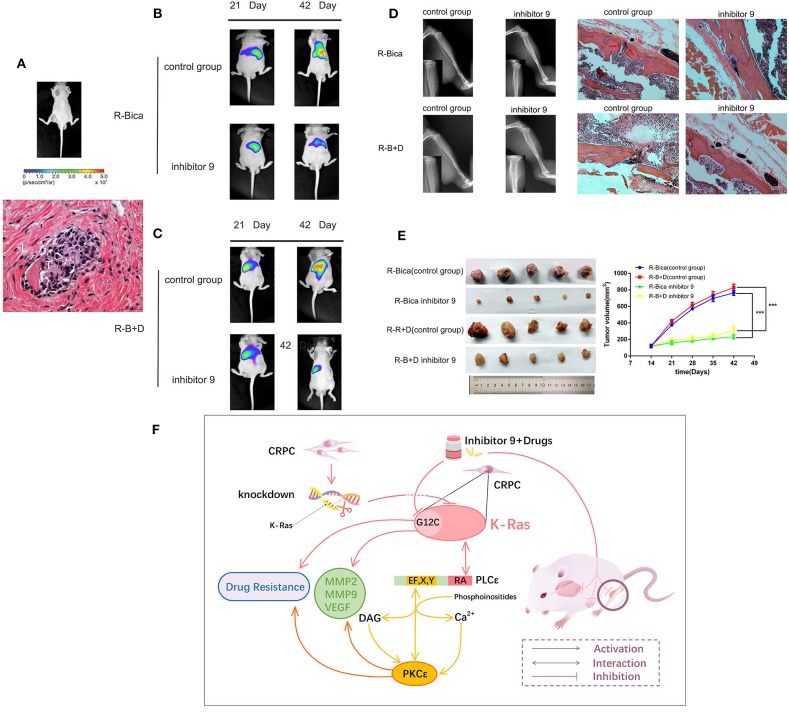
The combination therapy of inhibitor 9 and drugs can partially restore drug sensitivity and inhibit invasion and metastasis in CRPC cells in vivo. (A) No treatment with labeled cells had no fluorescence and H&E-stained sections of metastatic tumors in lung. T, tumor and L, lung. (B,C) The nude mice at 21 and 42 days after tail vein injection with CRPC cells transfected with lentivirus expressing firefly luciferase captured by bioluminescent imaging (signal intensity is represented by radiance, p/s/cm2/sr). (D) Hematoxylin and eosin staining and X-ray were used to detect the bone invasion of nude mice. (E) Tumor sizes and dynamic growth of subcutaneous tumors (***P < 0.001). (F) Schematic diagram summarizing our study: Knockdown of K-Ras can inhibit metastasis, invasion, and proliferation and partly restored drug sensitivity through PLCε/PKCε in CRPC cells; inhibitor 9 combined with drugs can down-regulate the expression of K-RasG12C and delay the progression of CRPC.